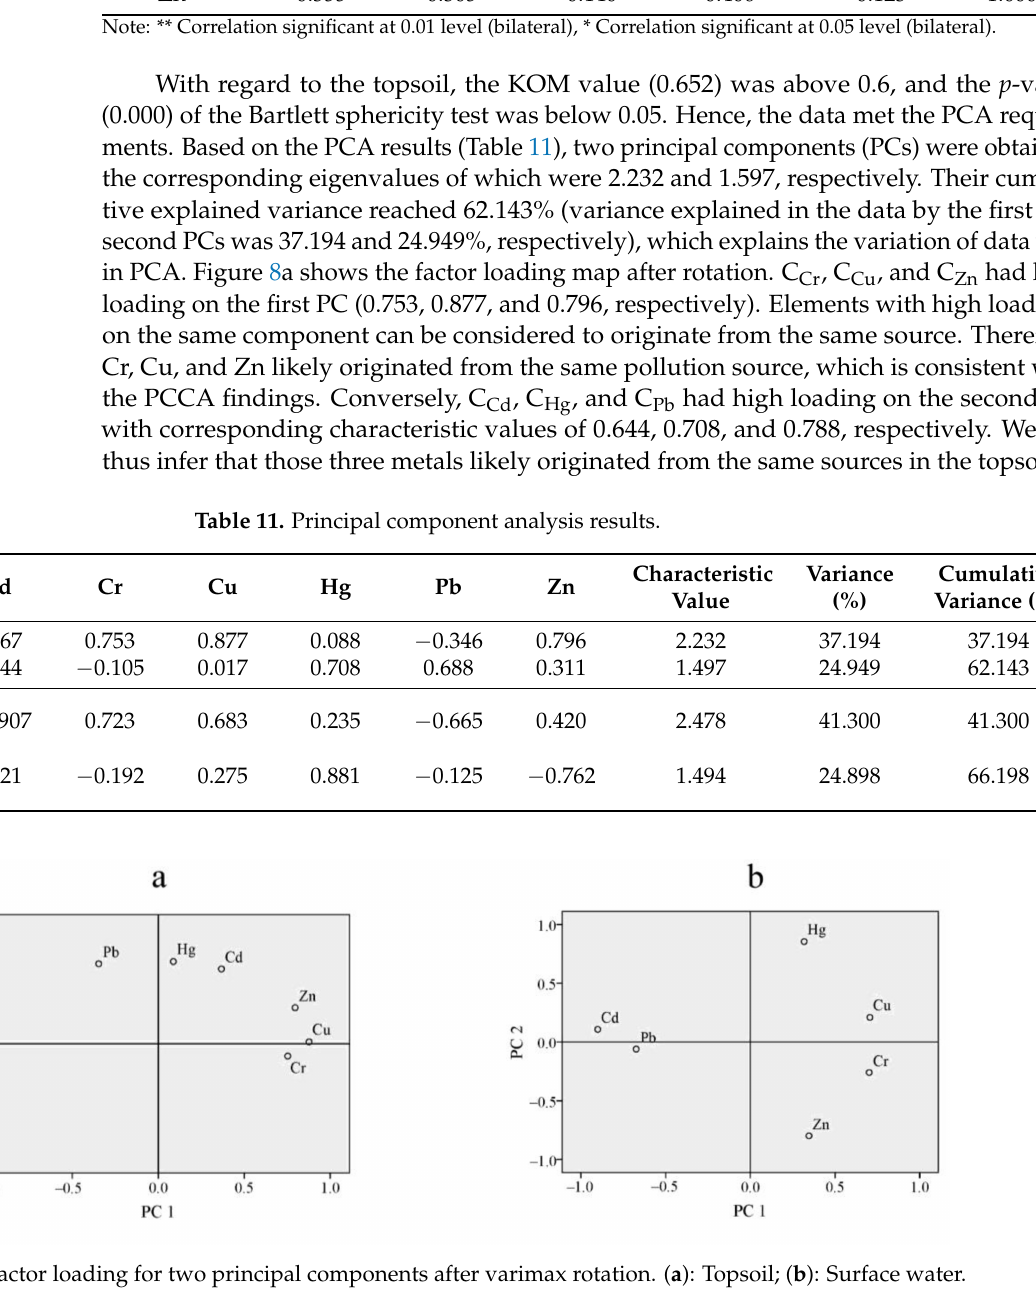
Figure 8. Factor loading for two principal components after varimax rotation. ( a ): Topsoil; ( b ): Surface